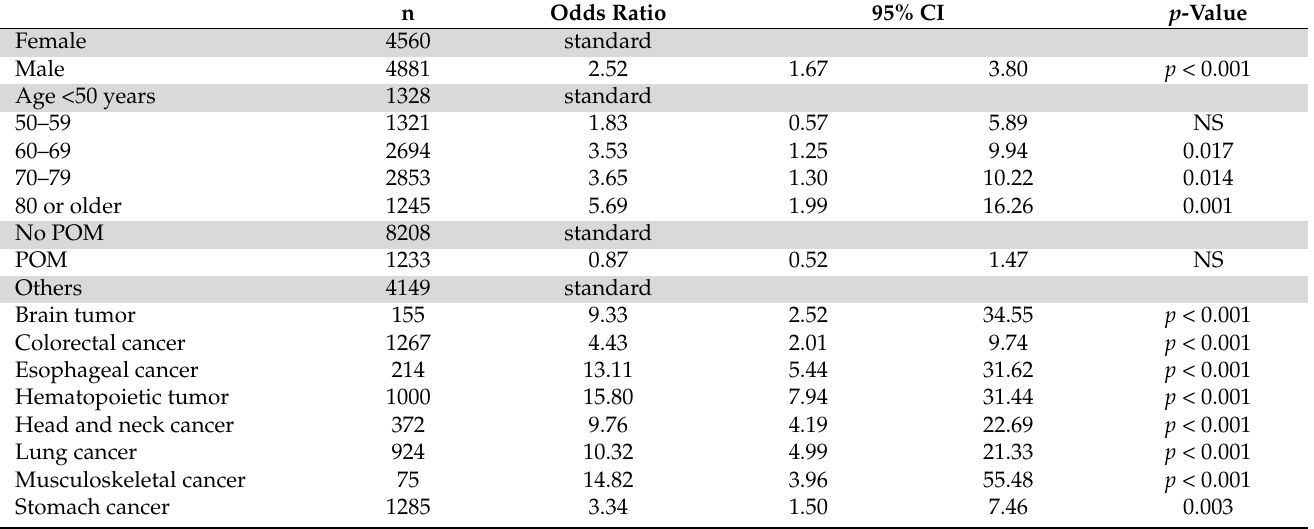
Table 4. Risk factors for pneumonia during